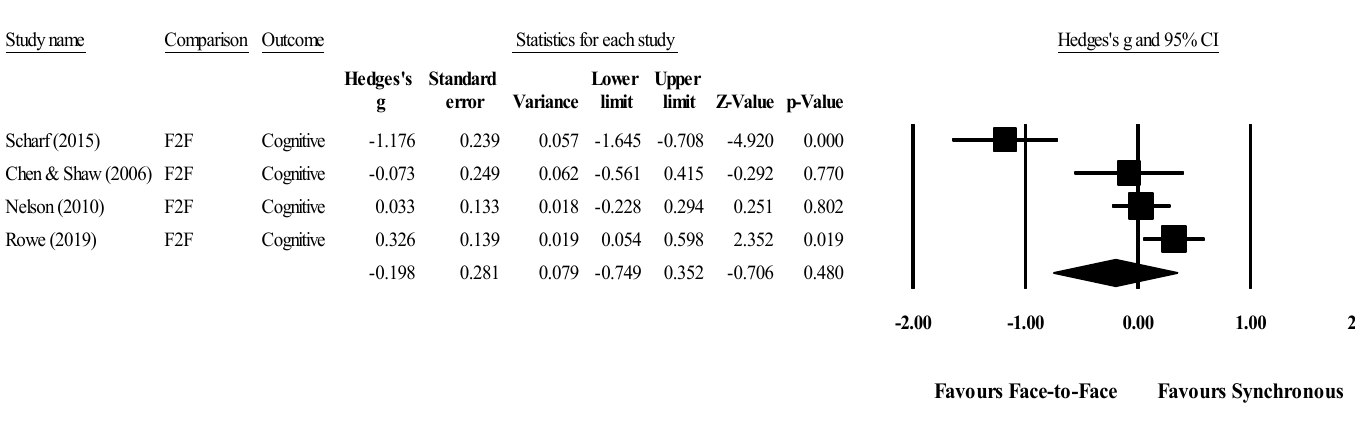
Forest Plot of Cognitive Outcomes (Synchronous vs.